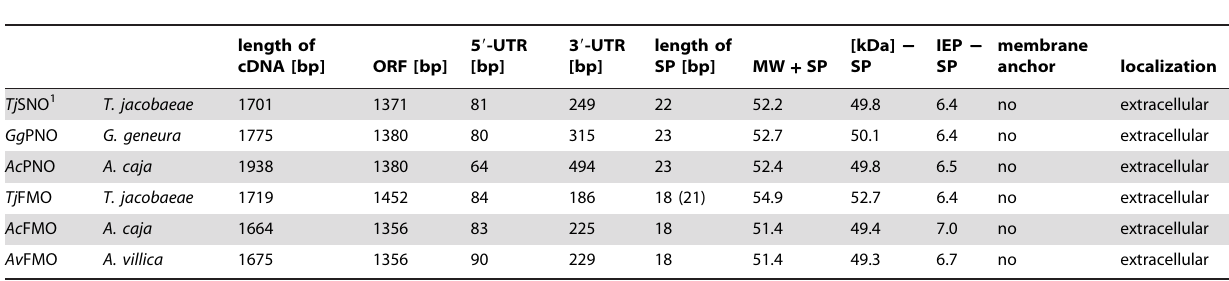
Table 1. Characteristics of FMO-like sequences identified from three Arctiid species.